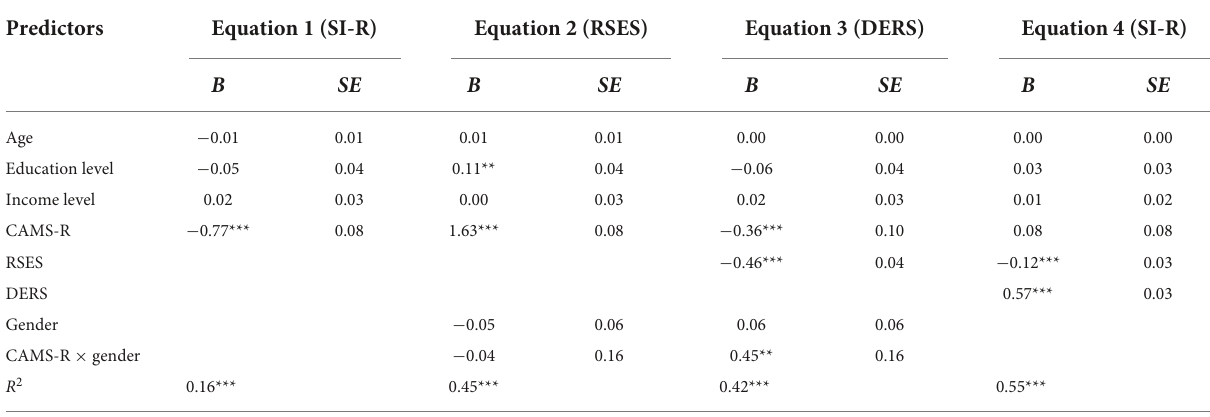
TABLE 4 Regression results of MODEL6 and